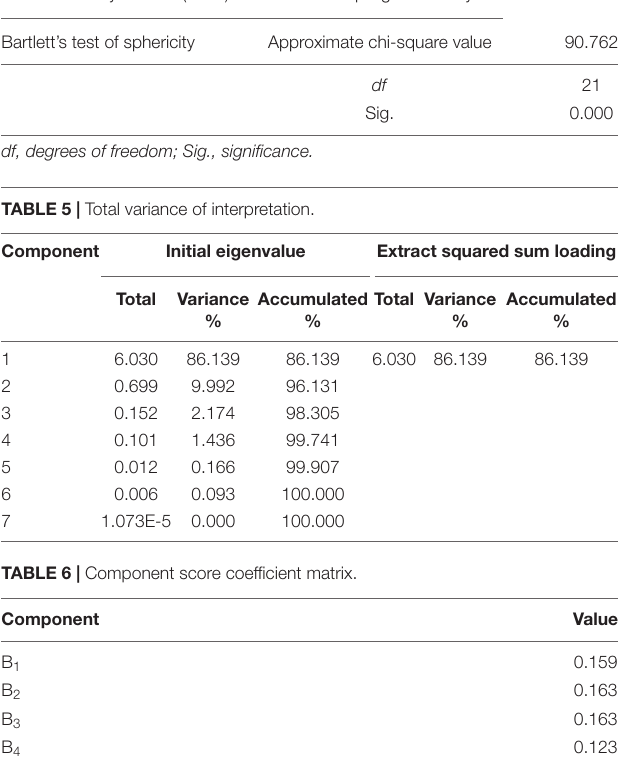
TABLE 4 | Kaiser–Meyer–Olkin (KMO) test and Bartlett’s test of sphericity. Kaiser–Meyer–Olkin (KMO) measure of sampling sufficiency